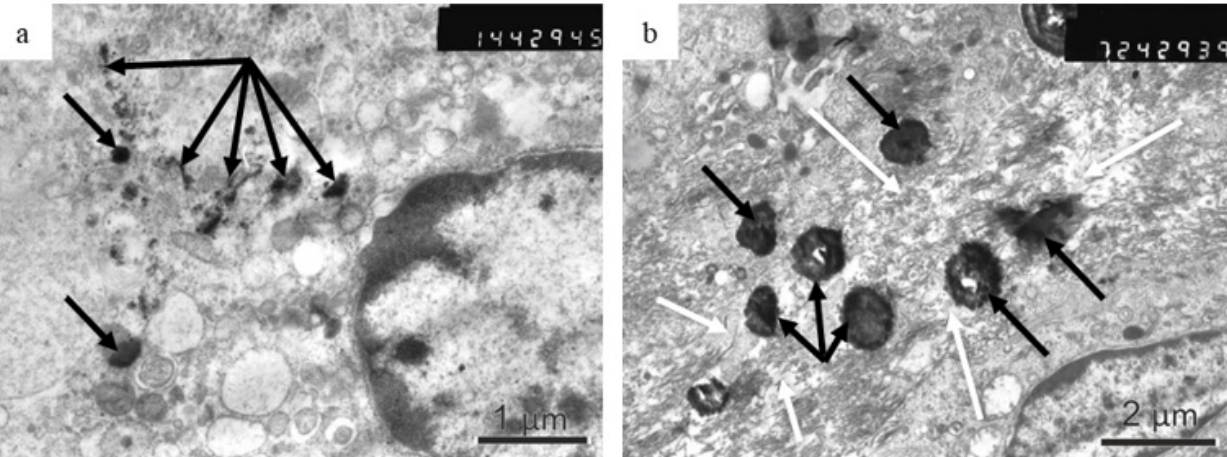
Figure 6. Electron microscopy images of atherosclerotic plaque structure treated with chemically modified Fe@C NPs after 14 days subcutaneous implantation in rats. ( a ) A macrophage of the laboratory rat with modified Fe@C NPs in its cytoplasm (indicated by black arrows). ( b ) Lowered density of collagen (bright areas indicated by white arrows) in the plaque structure in the intercellular space as a result of the interaction with modified Fe@C NPs (dark particles indicated by black arrows). The numbers in the right corner mean the number of EM scan.